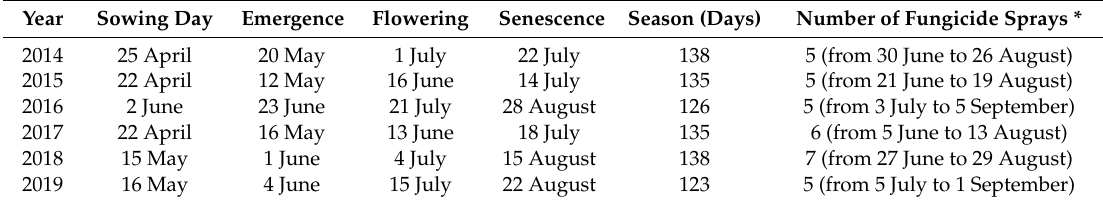
Table 1. Timing of the main phenological phases and agronomic practices in each growing